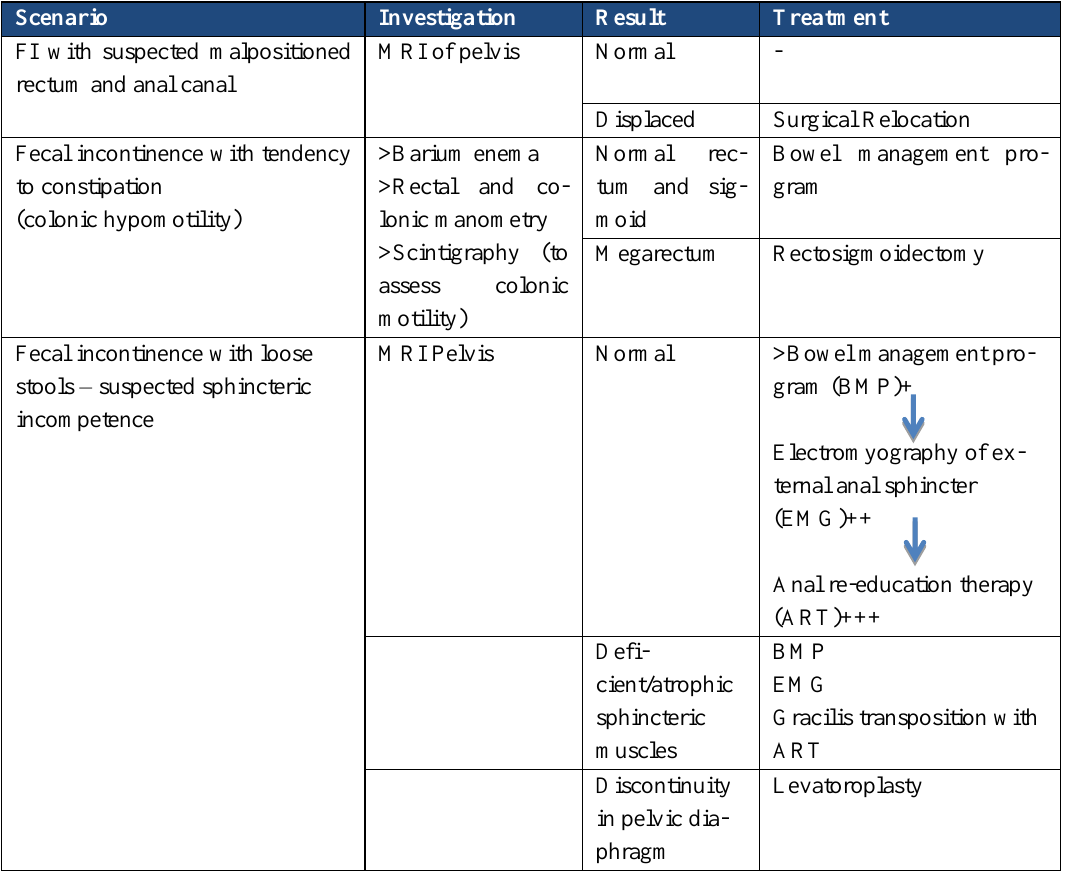
Table 5: Management of fecal